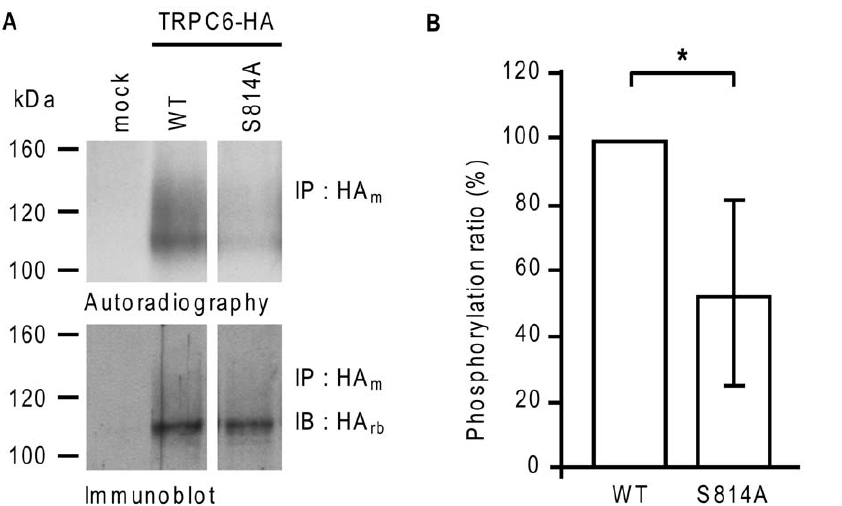
Figure 2. Metabolic labeling of TRPC6 and mutants reveals that Ser814 is phosphorylated. A , Metabolic labeling was carried out as described in Experimental Procedures . HEK 293T cells transfected with wild-type or mutant TRPC6 were lysed and TRPC6 was immunoprecipitated using a mouse monoclonal anti-HA antibody (HAm) and separated by SDS-PAGE. The autoradiogram (upper panel) and the immunoblot using a rabbit polyclonal anti-HA antibody (HAr) (lower panel) are representative of five independent experiments. B , The histogram represents the relative amount of phosphorylated TRPC6 calculated as the ratio of phospho-TRPC6 (densitometric analysis of autoradiograms) to total TRPC6 (determined by scanning and quantifying the immunoblot signals) for each sample. The histogram is the average 6 SD of five experiments. * P , 0.03.